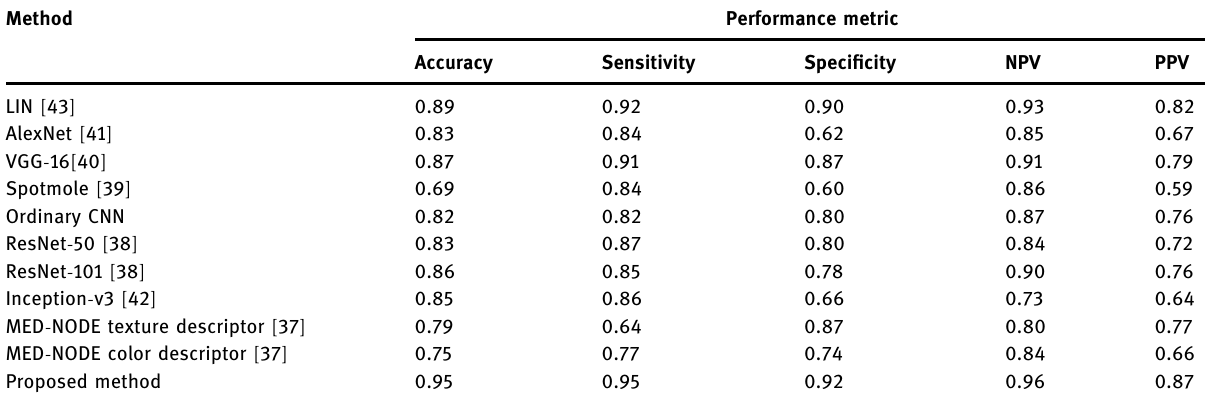
Table 5: E ffi ciency analysis of the proposed method compared with the other state - of - art techniques Method